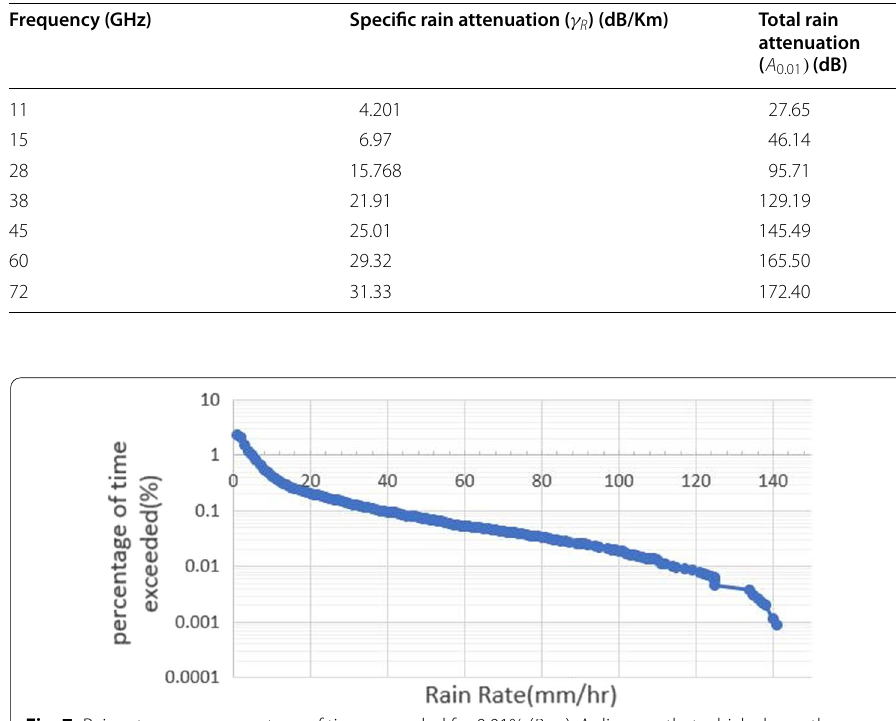
Fig. 7 Rain rate versus percentage of time exceeded for 0.01% ( R 0.01 ). A diagram that which shows the relationship between rain rate and percentage of time exceeded for 0.01%. Based on computation carried out using ITU-R rain-induced attenuation model, the R 0.01 is 113 mm/h for a frequency of operation 11-GHz and a path distance of 13.4 km (the distance between Jimma and